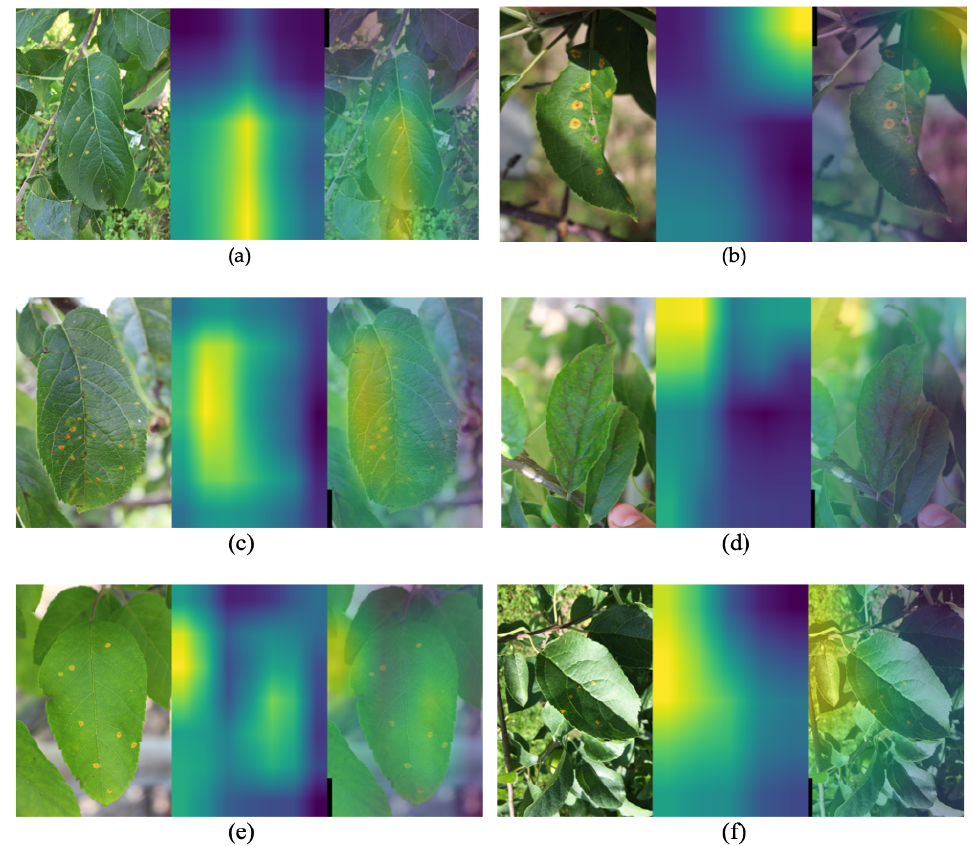
Figure 7. Damaged leaves ( a , c , e ) underlying leaves ( b , d , f ). Examples of images that were classified correctly belonging to Plant Pathology dataset. In each photo, from left to right, we see the original image, the generated heatmaps of the last convolution layer, and the overlap of the two images. The analysis shows that the classification had a negative impact for several reasons.